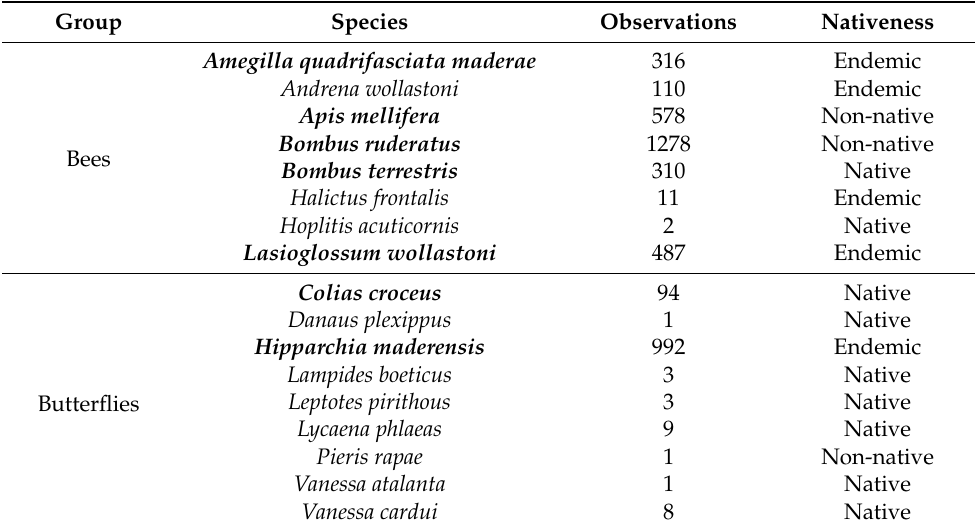
Table 1. The main groups and species of flower visitors observed on Echium candicans at Pico do Arieiro, their nativeness, and the overall number of visits to plants in the two study sites. The most common visitor species (highlighted in bold) were selected for the behavioral